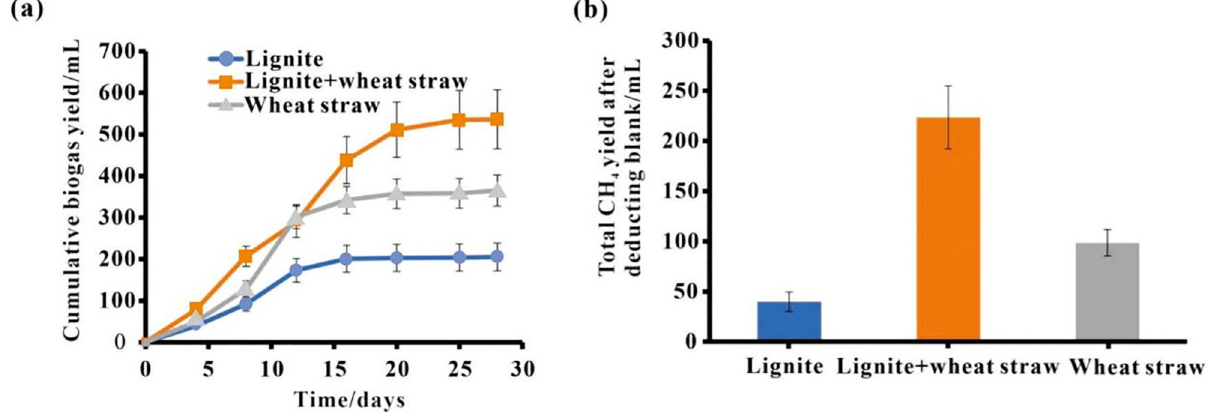
Fig 1. The cumulative biogas production (a) and total biomethane production (b) of different fermentation systems.